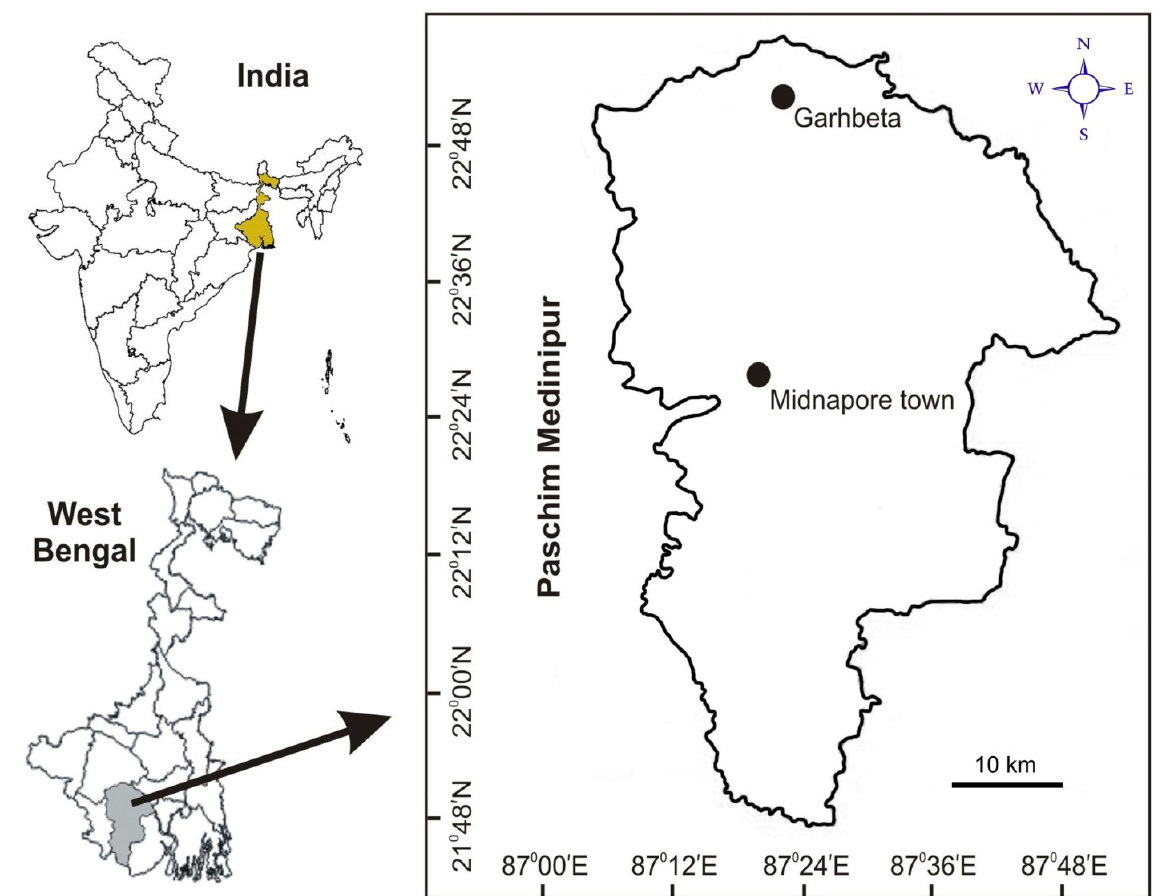
Fig 1 . Map showing sampling sites